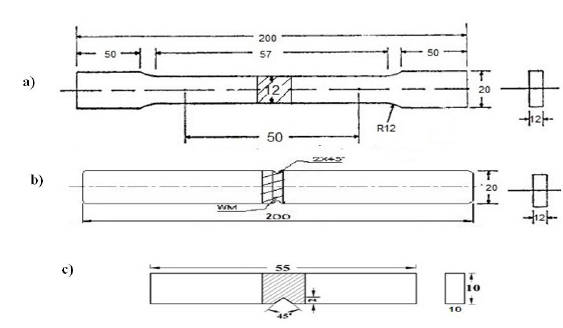
Figure 5: Dimensions of the specimens: a) smooth tensile specimen, b) notch tensile specimen, c) impact toughness specimen.